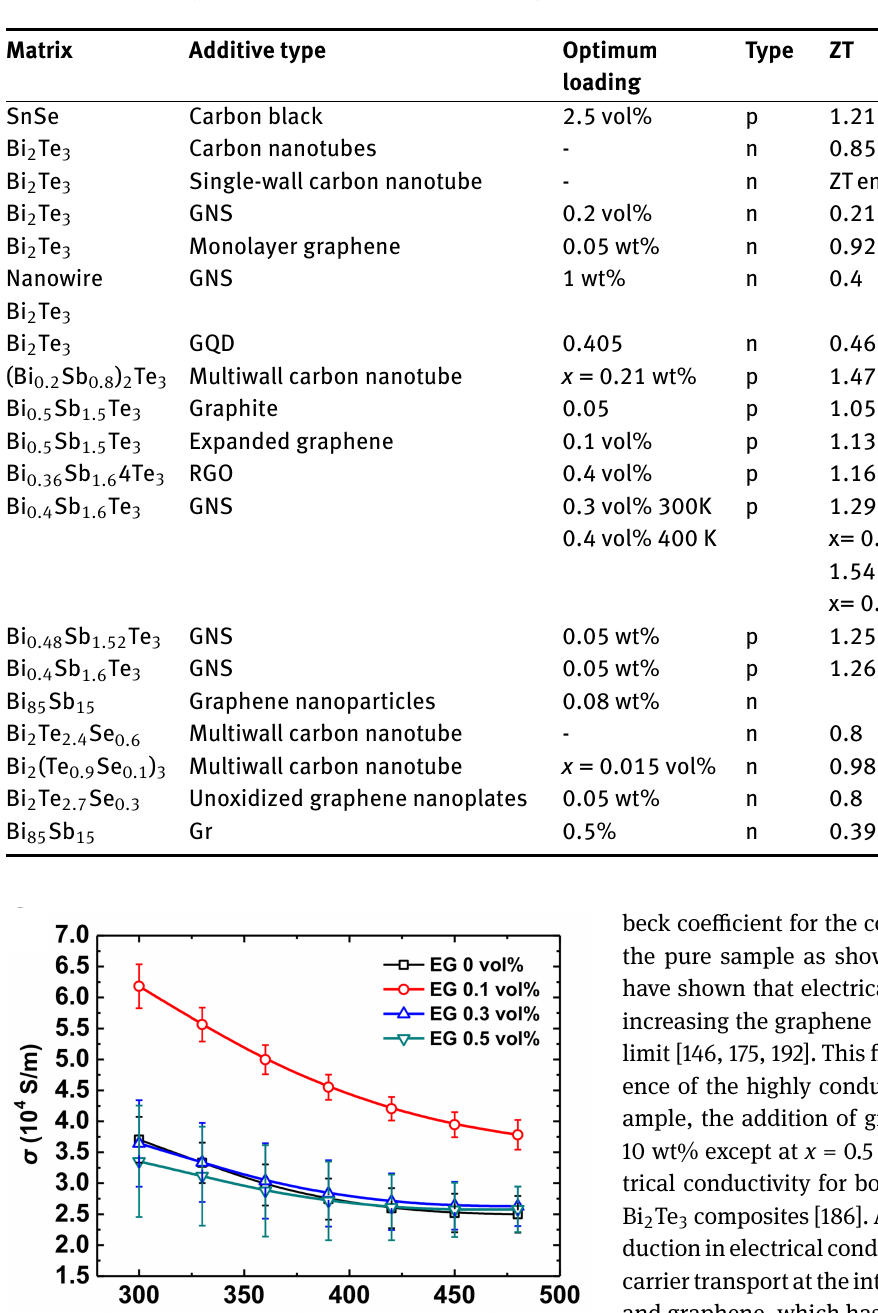
Table 5: ZT of some layered chalcogenides carbon-based composites.